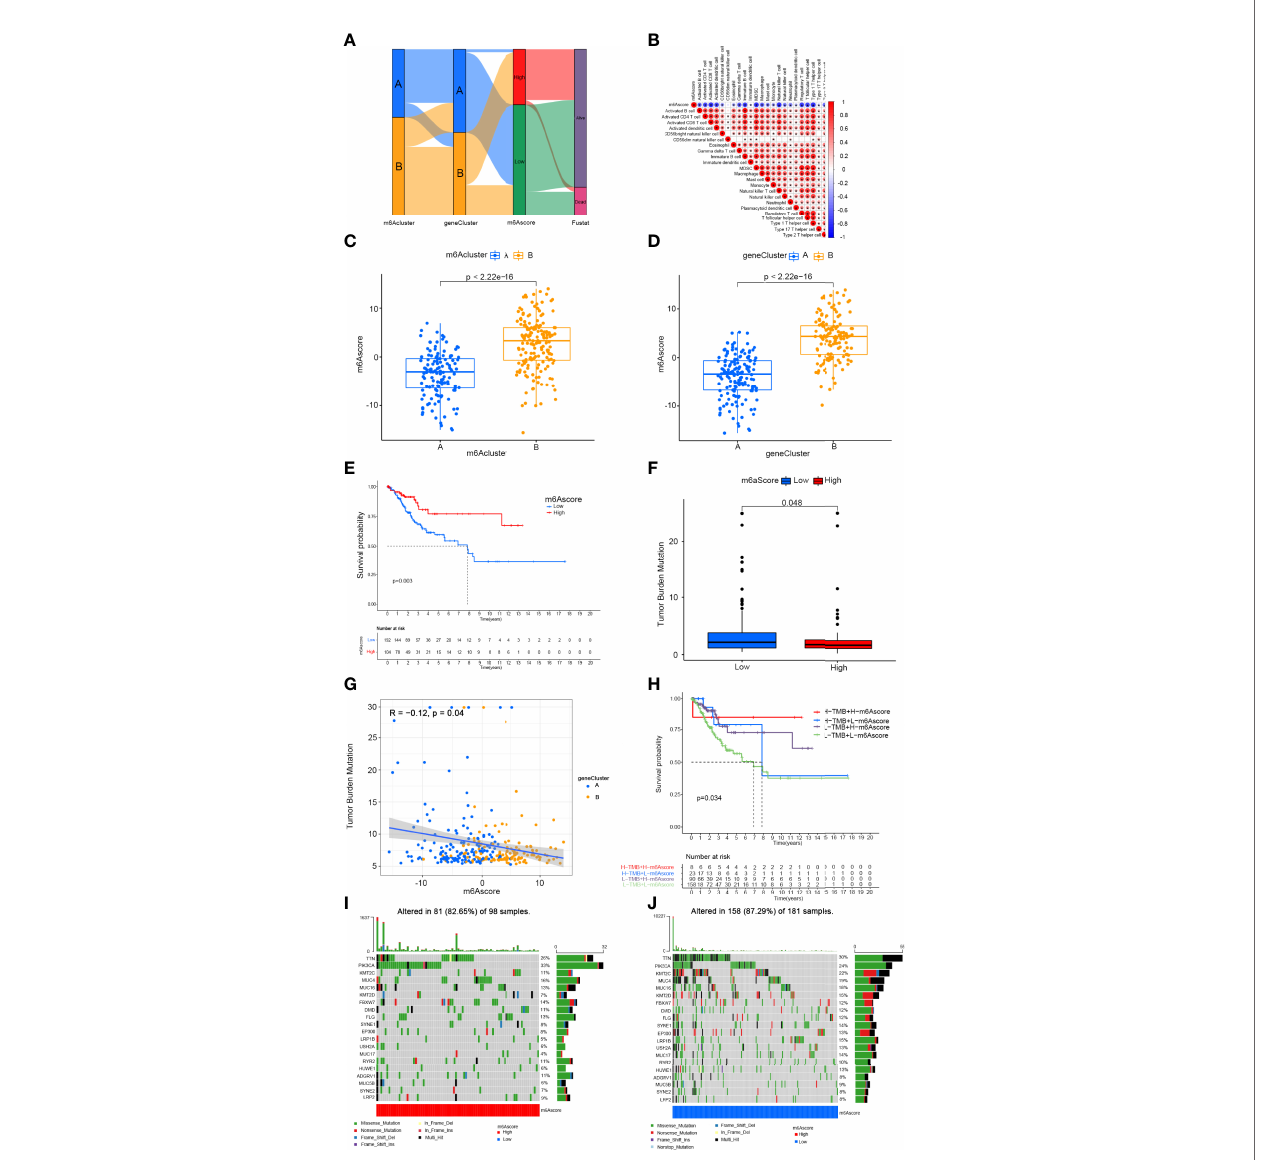
FIGURE 6 | Construction of m6A gene signature and exploration of its clinical signi fi cance. (A) Alluvial diagram showing the changes in m6Aclusters, gene clusters, m6Ascore, and survival status. (B) Correlation between m6Ascore and immune cells. Blue represents negative correlation and red represents positive correlations. (C) Variation analysis of m6Ascore between m6Aclusters. (D) Variation analysis of m6Ascore between gene clusters (E) Survival outcomes of patients by m6Ascore. The survival outcomes of patients in the low-m6Ascore group are better. (F) Tumor mutation burden between different m6Ascore groups. (G) M6Ascore and tumour mutation burden (TMB) were negatively correlated (R= − 0.12, P=0.04). (H) The survival curve of patients in the subgroup of m6Ascore and TMB. (I) Tumor somatic mutation waterfall chart of high m6Ascores. (J) Tumor somatic mutation waterfall chart of low m6Ascores. Each upper bar graph shows the tumour mutation burden (TMB), and the number on the right represents the mutation frequency of each